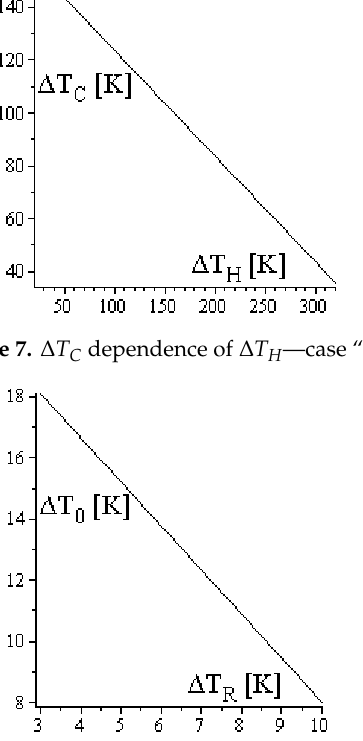
Figure 8. Δ T 0 dependence of Δ T R —case “c”.